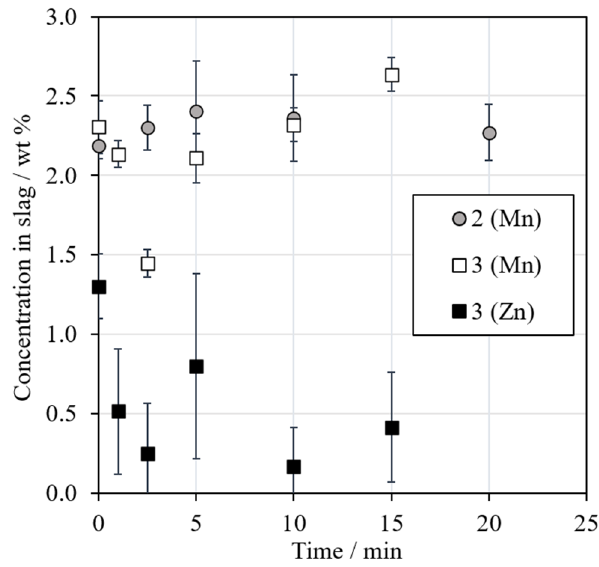
Figure 10. Concentrations (wt %) of manganese and zinc in slag as a function of the reduction time.